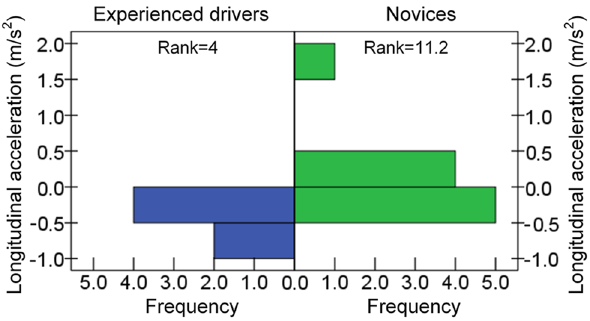
Figure 10. Difference in longitudinal acceleration.